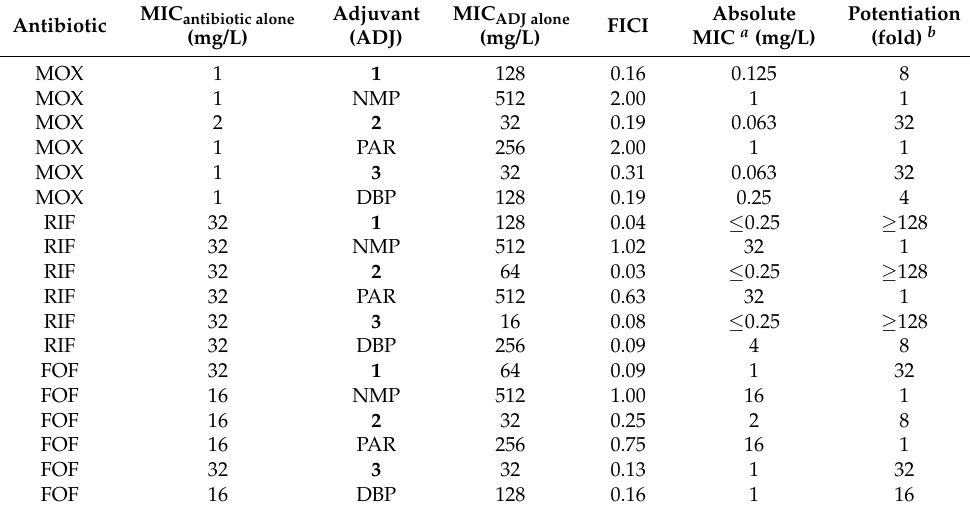
Table 1. Combination studies of TOB-EPIs ( 1 , 2 , or 3 ) or EPIs (NMP, PAR or DBP) with moxifloxacin (MOX), rifampicin (RIF) or fosfomycin (FOF) against wild-type P. aeruginosa PAO1 strain. MIC antibiotic alone Adjuvant MIC ADJ alone Absolute Antibiotic FICI MIC a (mg/L) (ADJ) (mg/L)